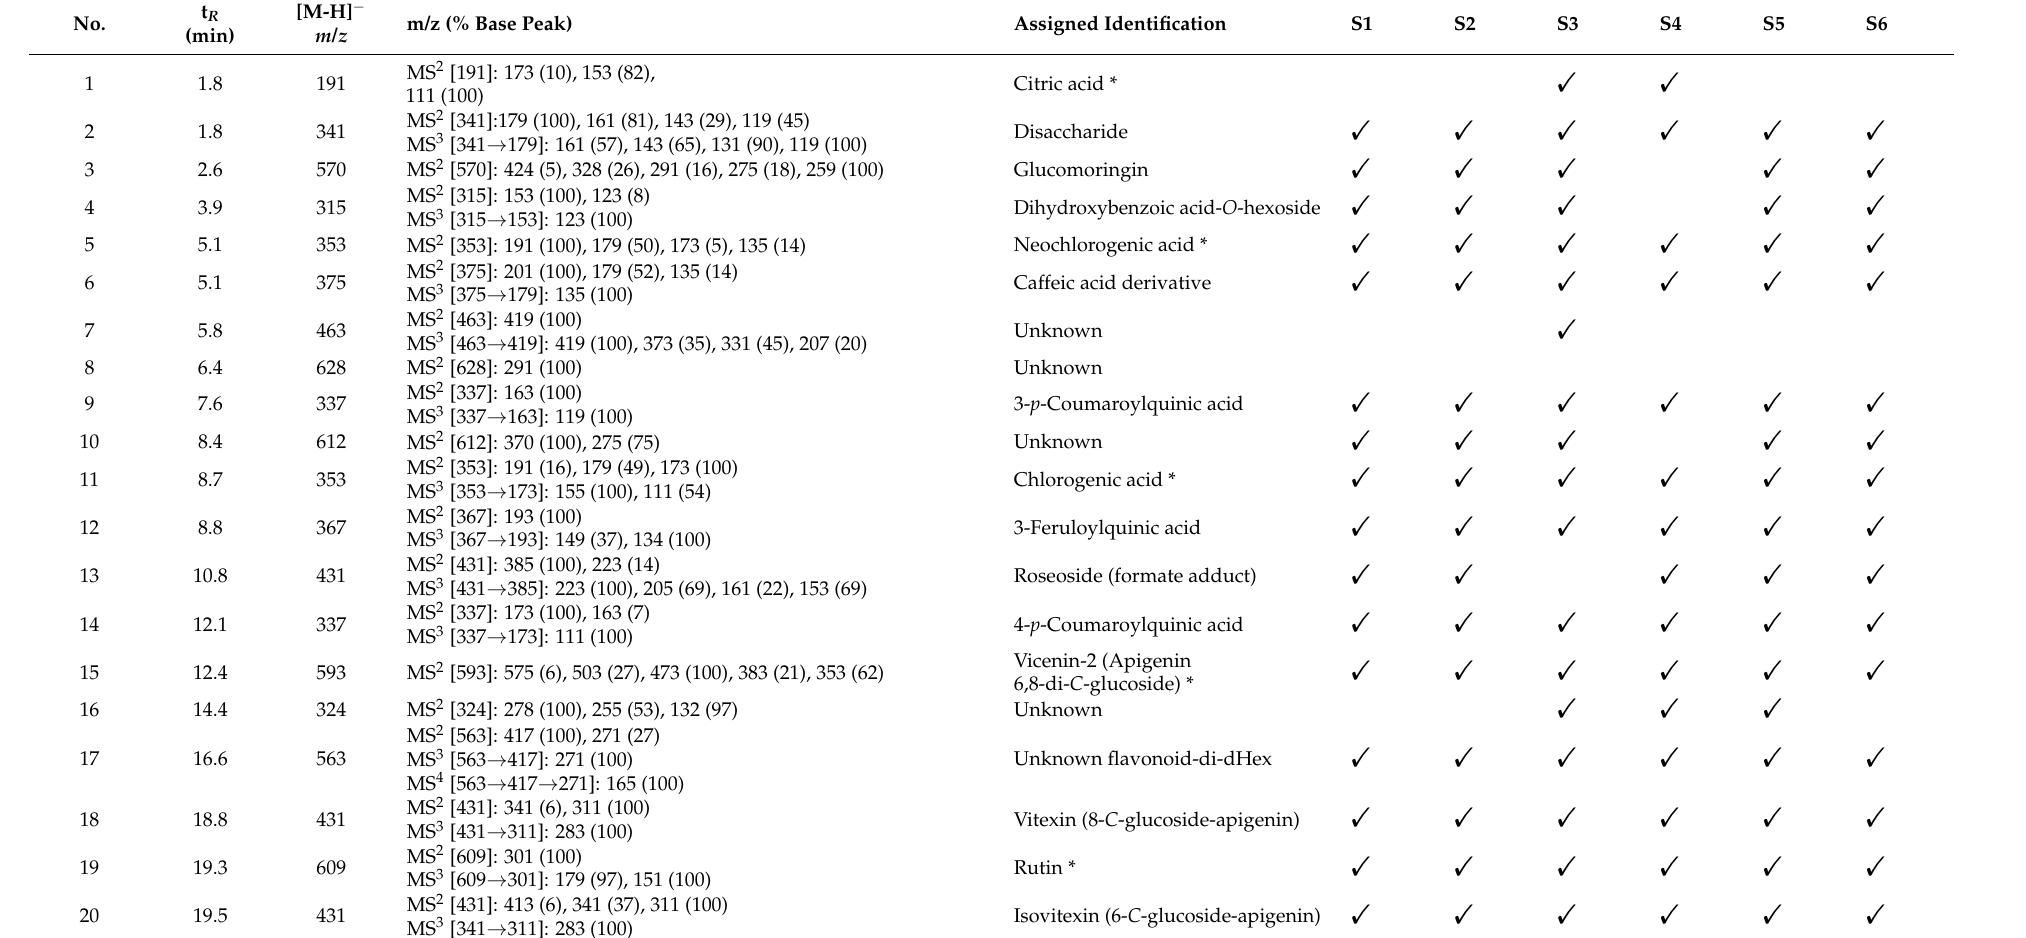
Table 2. Characterization of phytochemicals found in extracts of food supplements of M. oleifera by HPLC-DAD-MS n